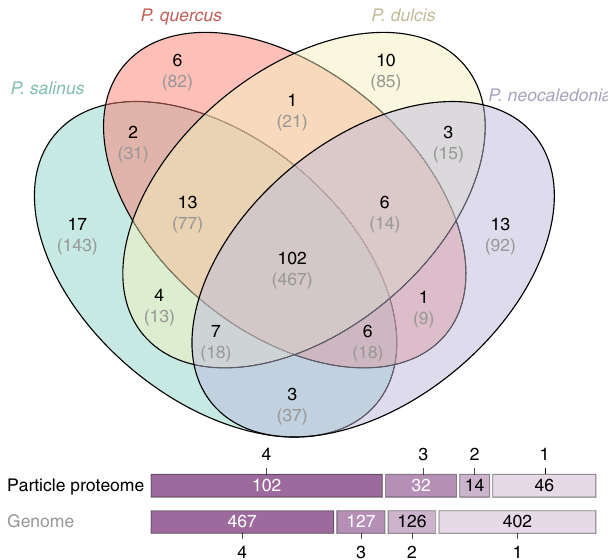
Fig. 7 Venn diagram of the particle proteomes of four different pandoravirus